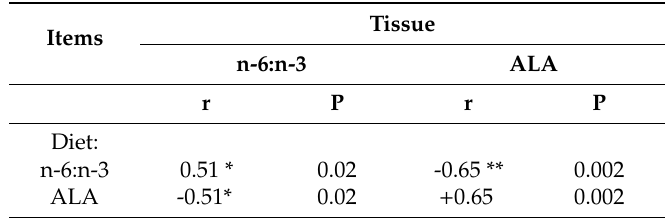
Table 6. Pearson correlation between dietary and tissue n-3:n-6 polyunsaturated fatty acid (PUFA) and α -linolenic fatty acid